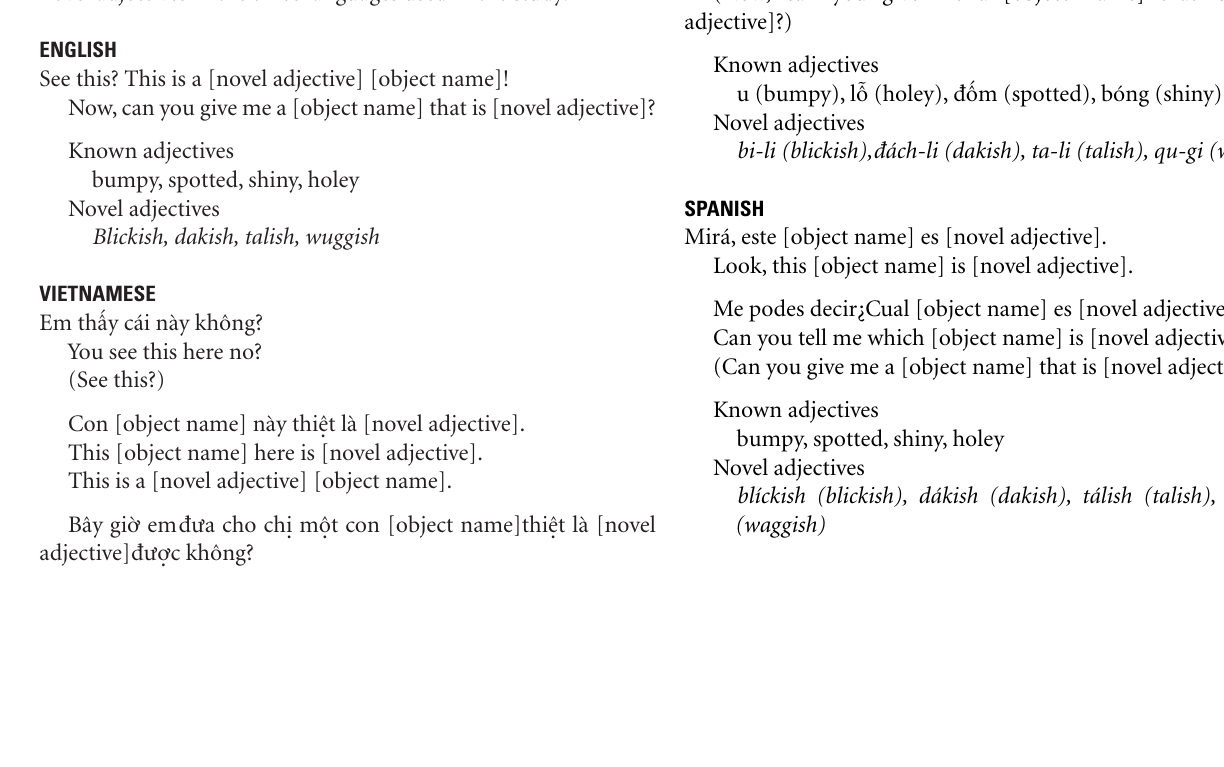
Lists of test phrases used for the adjective task, and known and novel adjectives in the three languages used in the